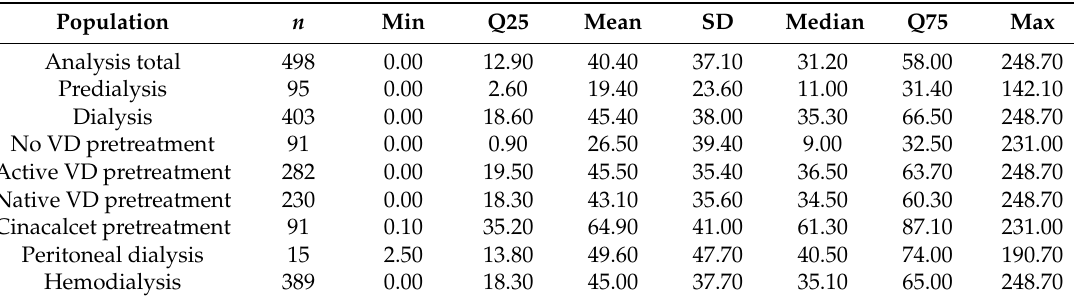
Table 8. Duration of sHPT in months before study start.